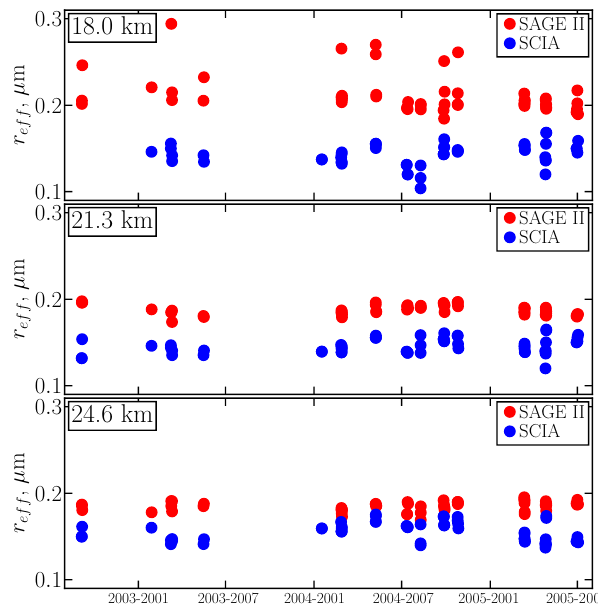
Figure 15. Effective radii from collocated SCIAMACHY and SAGE II measurements at 18, 21.3, and 24.6km